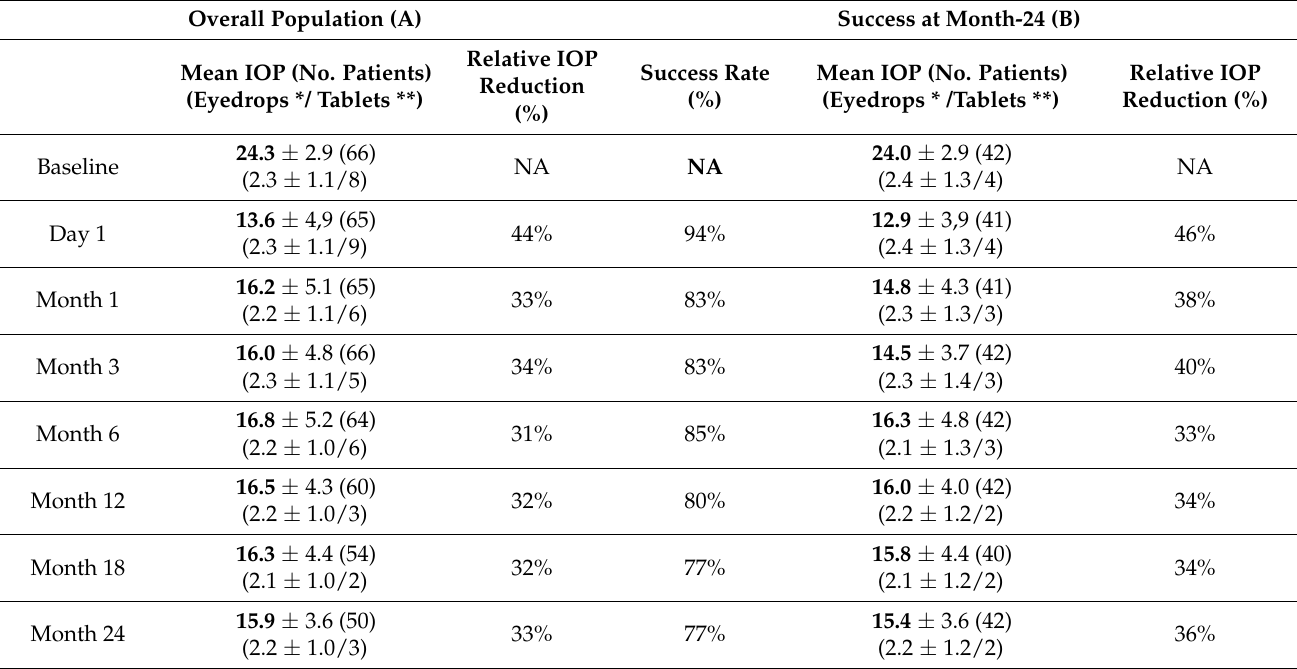
Table 2. Intraocular pressure, glaucoma medication and success rate during follow-up with number of glaucoma medications in the overall population (A) and in patients with success at Month 24 (B). (Efficacy results). Overall Population (A)